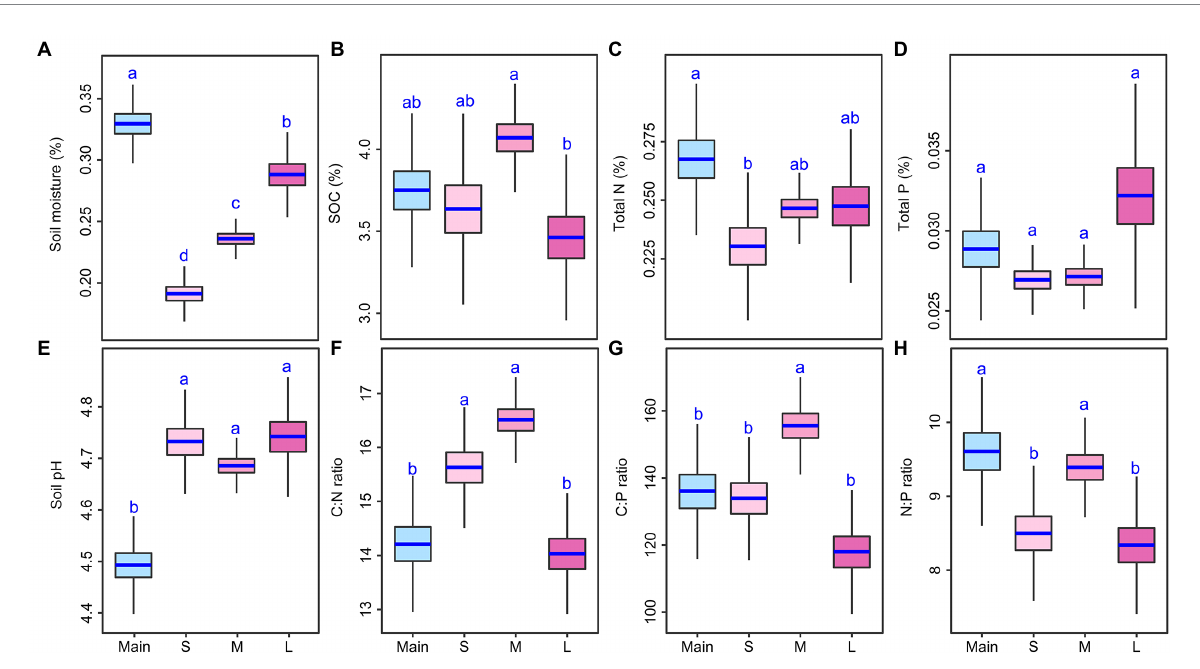
FIGURE 1 Differences in soil abiotic variables (A–H) among the mainland (Main) and three island types (S: small islands; M: medium islands; L: large islands). Boxplots indicate the medians and upper and lower quartiles of the posterior distribution. Different letters indicate a credibly different posterior distribution among the mainland and three island types (Bayesian-ANOVA, 95% highest density intervals of the posterior difference between each two groups falls above or below